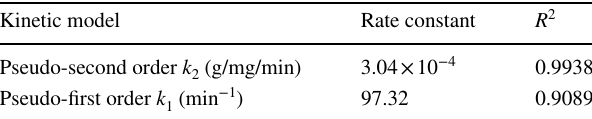
Table 5 Pseudo-first-order and pseudo-second-order constants of pyr- ene Kinetic model